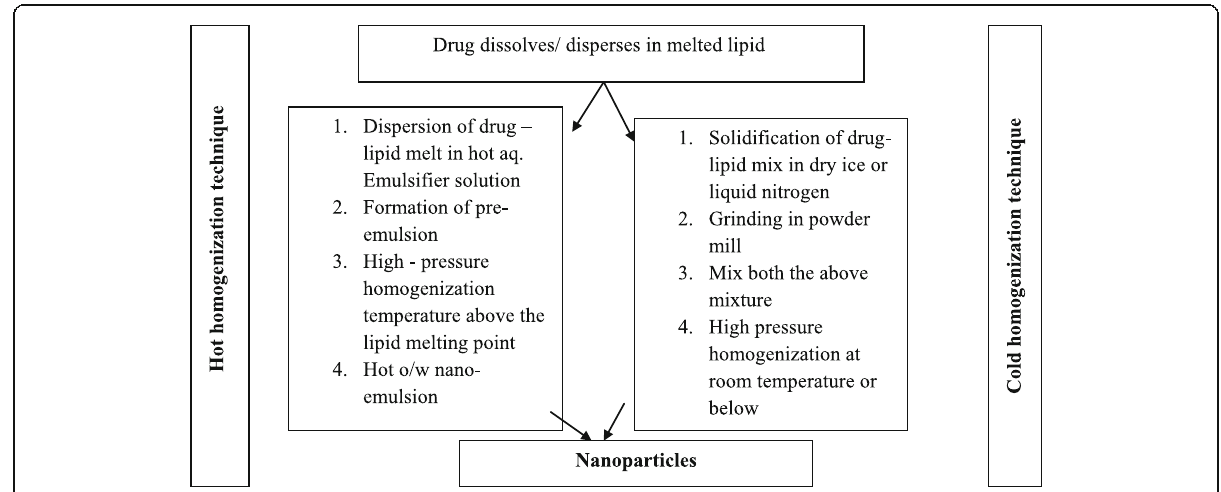
Fig. 5 Hot homogenization and cold homogenization loading